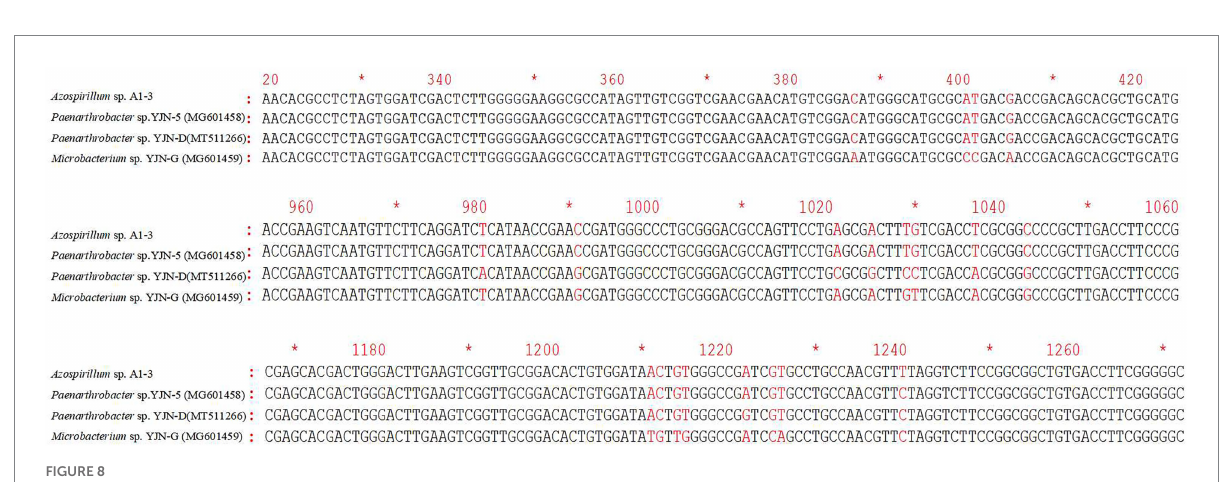
FIGURE 8 The differences of ipaH gene sequences in Azospirillum sp. A1-3 and other iprodione-degrading